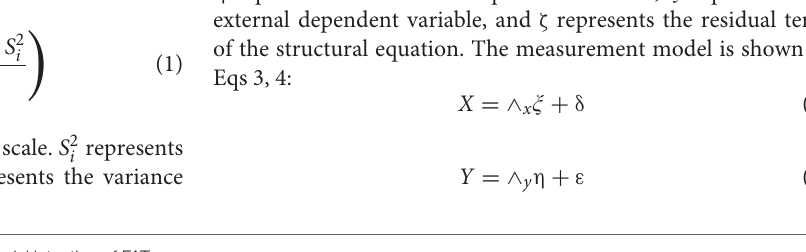
TABLE 3 | Questionnaire on the psychological entrepreneurial intention of FAT. Basic